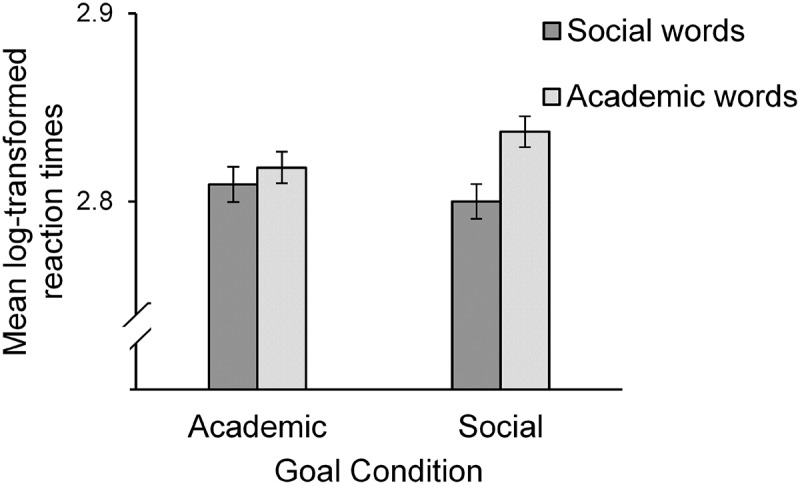
Mean log-transformed reaction times to words in the social category versus words in the academic category depending on social versus academic priming condition. The mean log-transformed reaction time for control words served as the covariate. Error bars represent ± 1 SE.